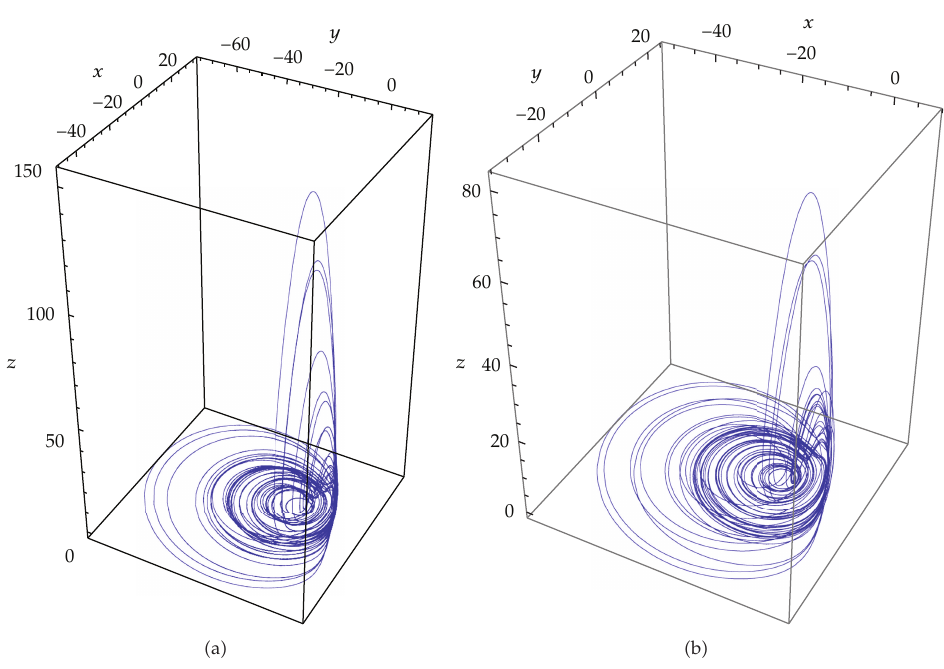
Figure 6: Phase plot of chaotic attractor in x - y - z spaces, with a (cid:8) 0 . 25, b (cid:8) 3, c (cid:8) 0 . 5, d (cid:8) 0 . 05: (cid:3) a (cid:4) α (cid:8) α (cid:8) 0 . 98, α (cid:8) α (cid:8) 0 . 99, (cid:3) b (cid:4) α 1 2 3 4